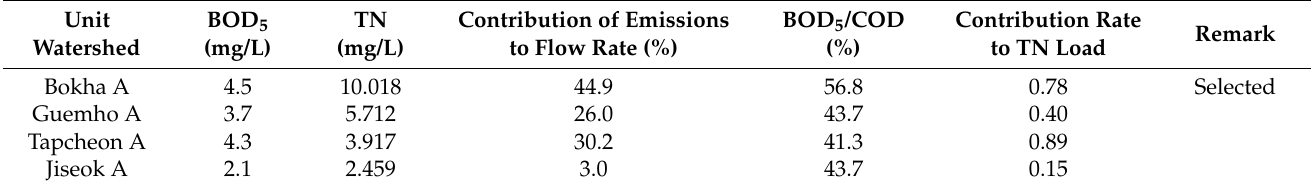
Table 1. Criteria for survey targets in the first-priority unit watershed in each water system (2017–2018).